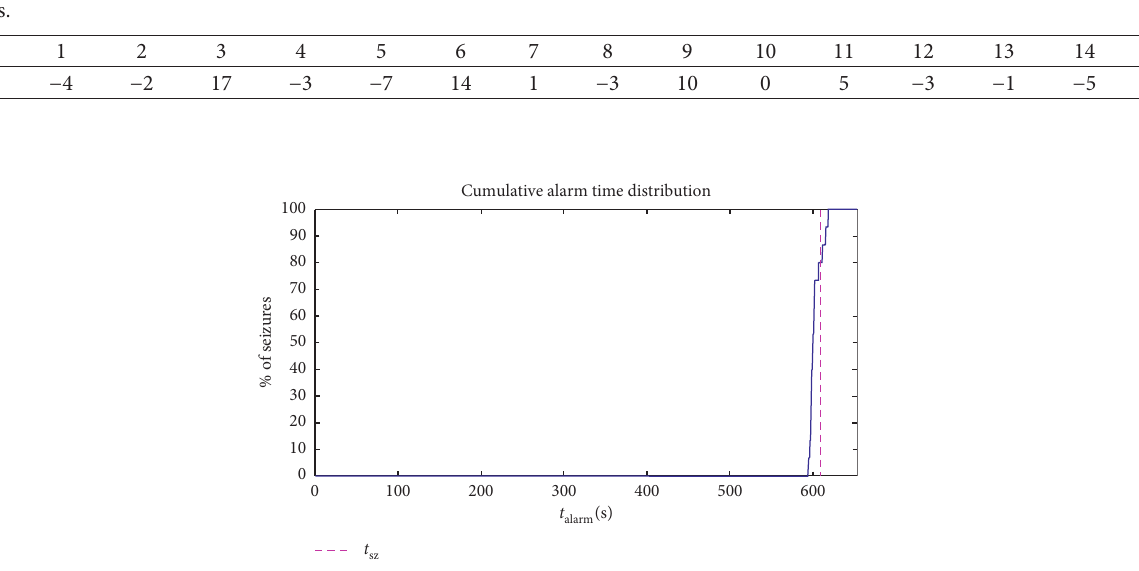
Figure 4: Cumulative alarm time distribution for patient #9. The dashed vertical line refers to the seizure onset time provided by the neurologists.